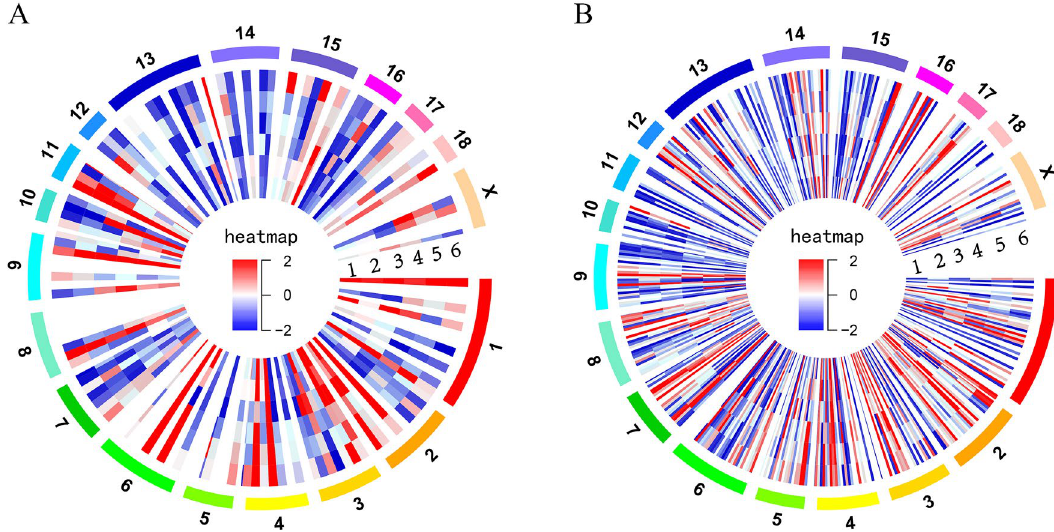
Figure 2. Differential expression (DE) analysis of lncRNA and mRNA in Meishan and Duroc M2 follicle.